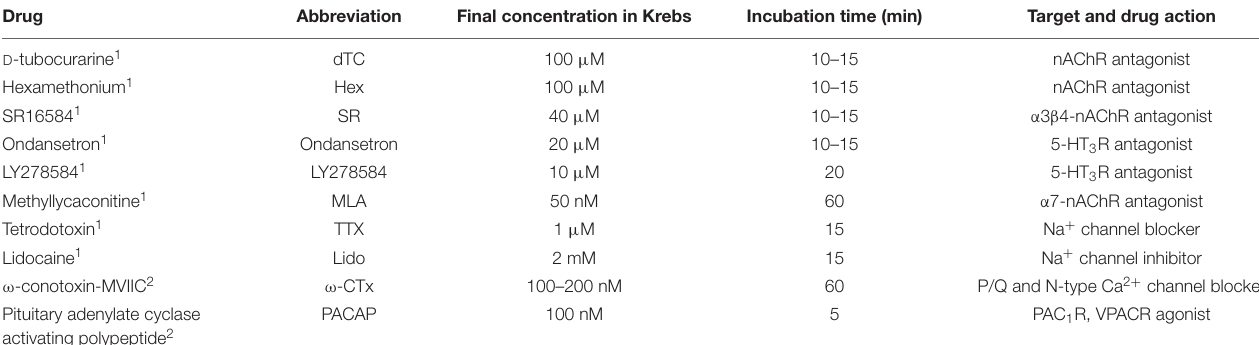
TABLE 1 | Test drugs were applied to colon explants in Krebs solution either by the perfusion system 1 or by pipetting them directly into the chamber 2